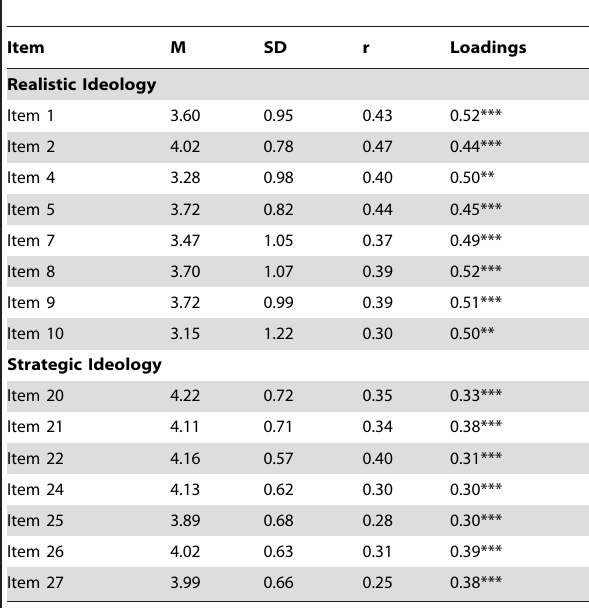
Table 4. Factor Loadings for 15-item GIS-family